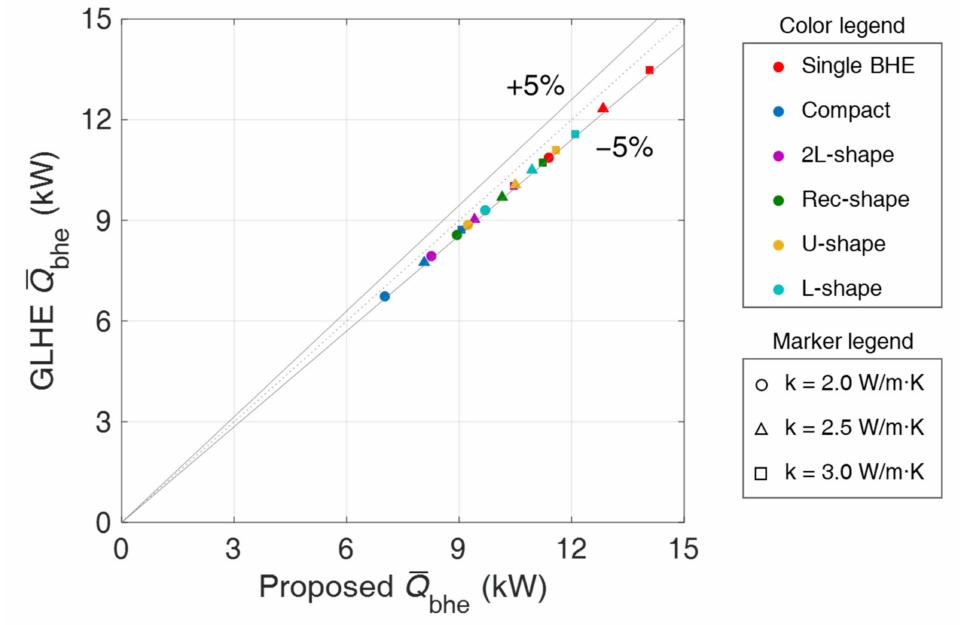
Figure 8. Comparison between proposed Q bhe and GLHE (reference) Q bhe .